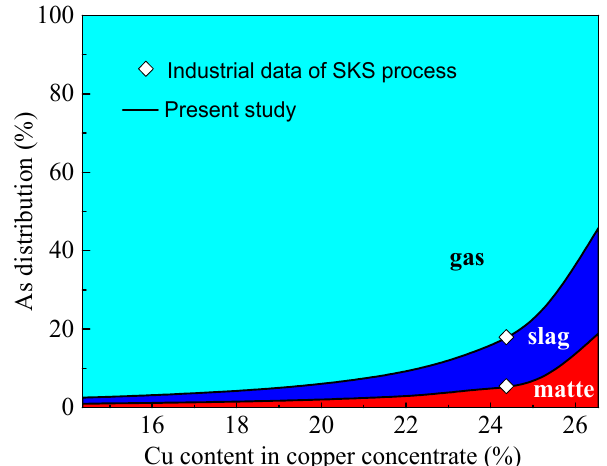
Figure 1. Comparison between the actual production and simulation results of the effect of Cu content in concentrate on the distribution of arsenic among the gas, slag and matte phases.